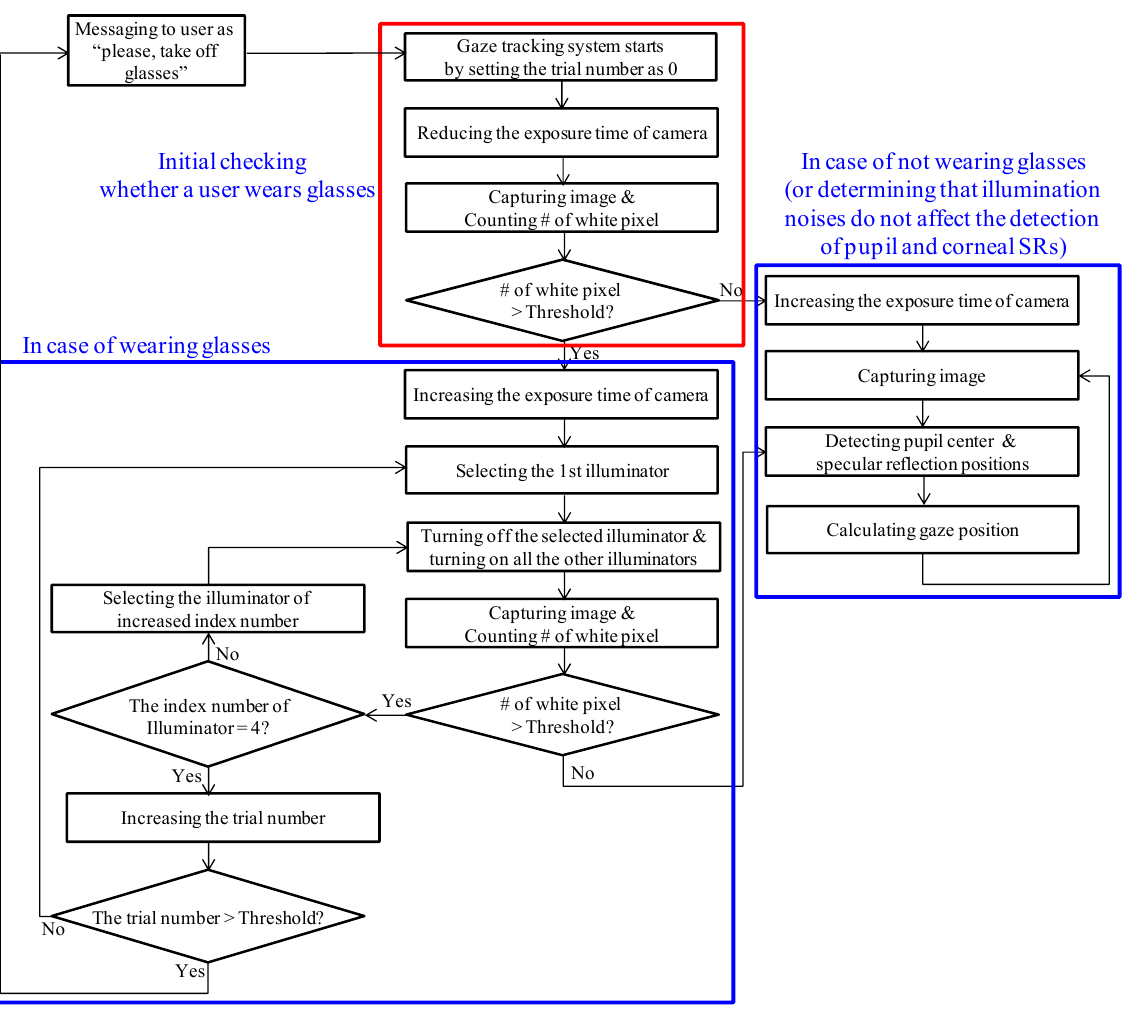
Figure 2. Overall procedure for the proposed gaze tracking